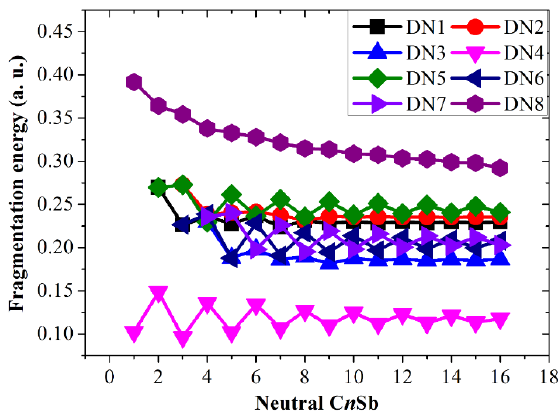
Figure 15. Fragmentation energies of neutral C n Sb clusters. DNx corresponds to different dissociation channels, as shown in the text.